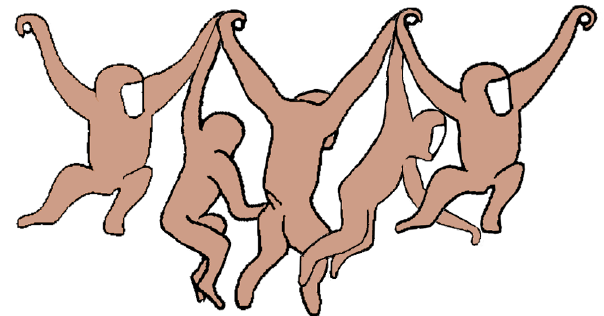
Figure 1. The brachiation motion of the gibbon.